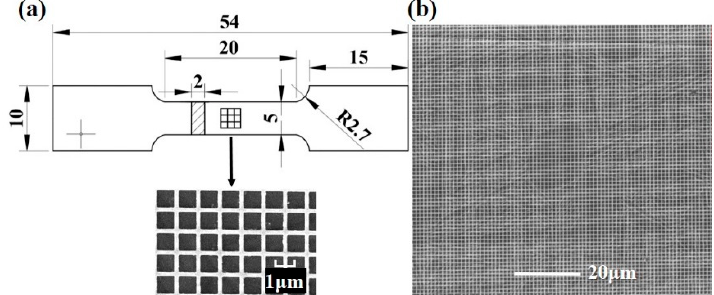
Figure 3. Schematic of the geometry and micro-grid of the tensile specimen ( a ) and area of interest (AOI) ( b ). The unit of dimension of sample is mm.